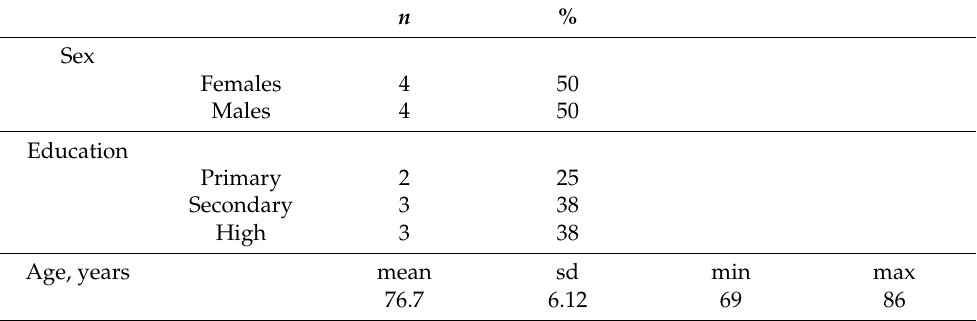
Table 1. Demographic characteristics.